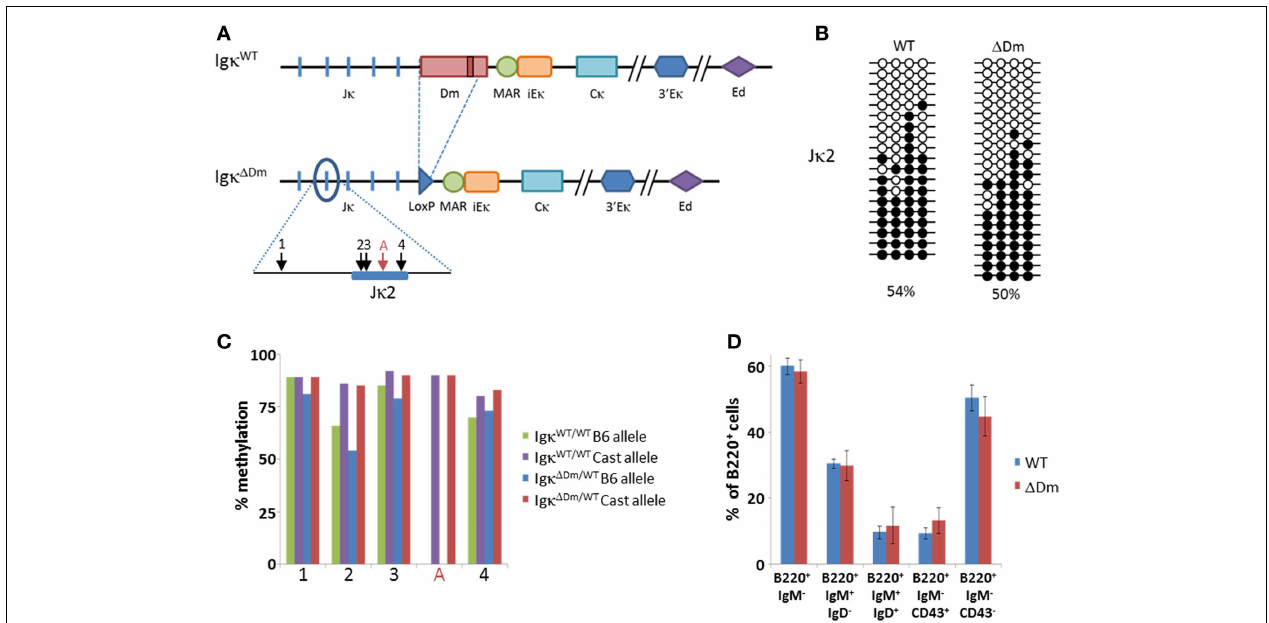
CD19 + bone marrow pre-B cells from Rag1 − / − C57BL/6/Castaneous IgH-3H9-Tg mice with or without a deletion of the Dm element on the C57BL/6 (B6) allele. Copies (1600–3000) of each CpG from each genotype were analyzed. Alleles were differentiated by strain-specific polymorphic sites within the amplified regions.The methylation state of each CpG is summarized graphically. (D) Summary of proportions of B cell populations within bone marrows ofWT and ∆ Dm mice. Error bars mark standard deviation. Six mice were analyzed in each group. Representative FACS plots can be seen in Figure S4 in Supplementary